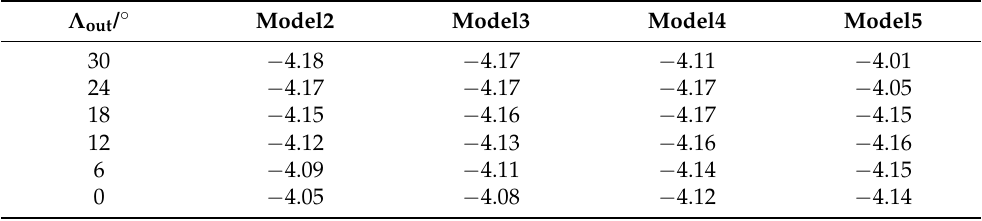
Table 9. The roll damping of pre-selected models under the stability augmentation adjustment when Ma =